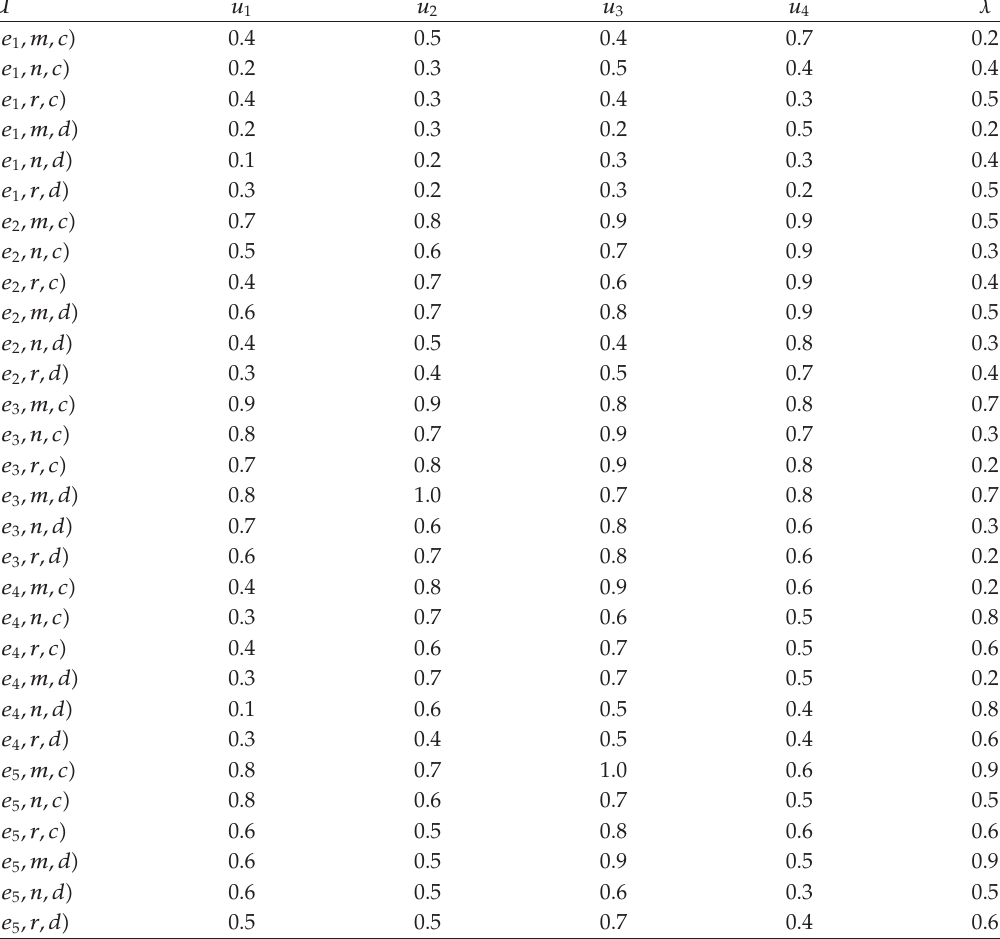
Table 6: 1-rejected opinions of generalized fuzzy soft expert set.